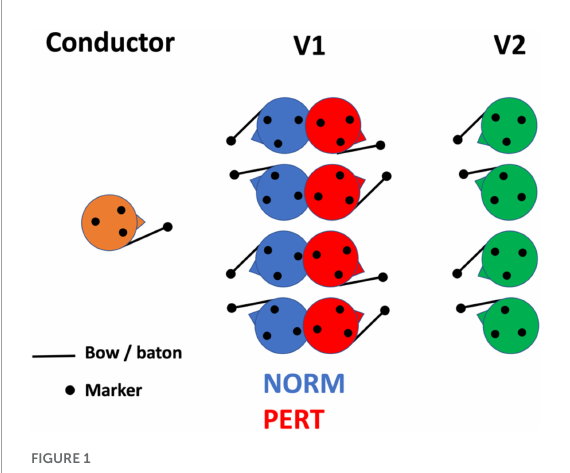
FIGURE1 Position of the violinists whose motion has been recorded in normal (NORM) and perturbed (PERT) conditions. The experimental manipulation consisted in changing the arrangement of V1 with respect to the conductor and V2, preventing V1 from seeing the conductor and instead making them face